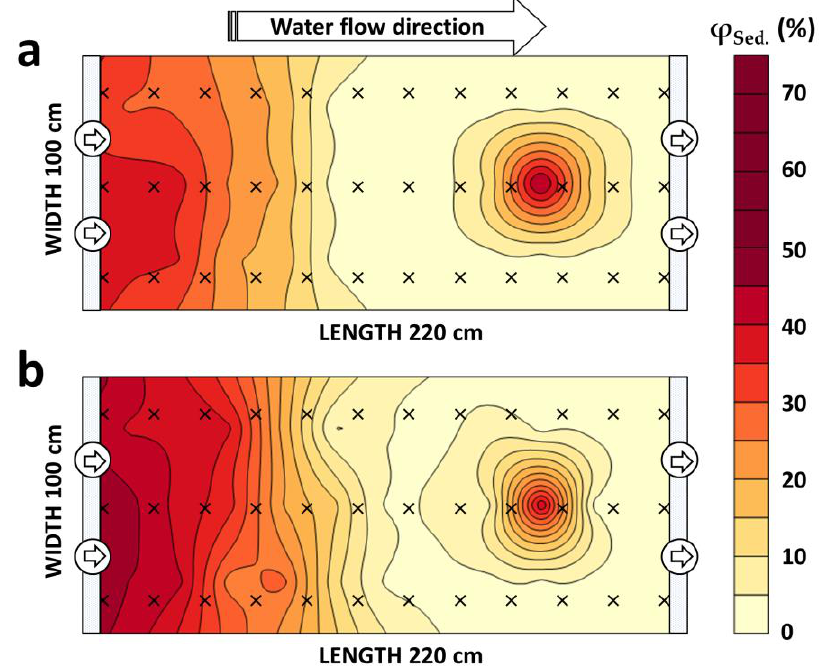
Figure 6. Clogging contours in the HSSF CW based on ( a ) the two-probe method and ( b ) the four-probe method (plan view; different colors represent various sediment fractions ( v / v ); the crosses represent the positions of stainless steel bar electrodes; the arrows represent the flow direction). ϕ